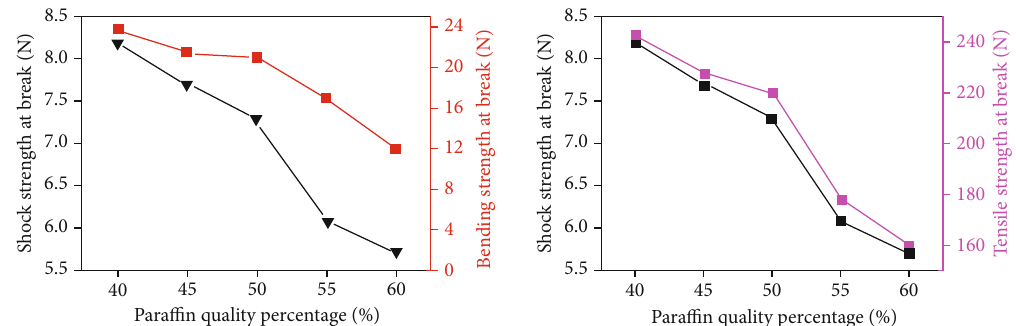
Figure 9: Bending and tensile strength break at di ff erent proportions of para ffi